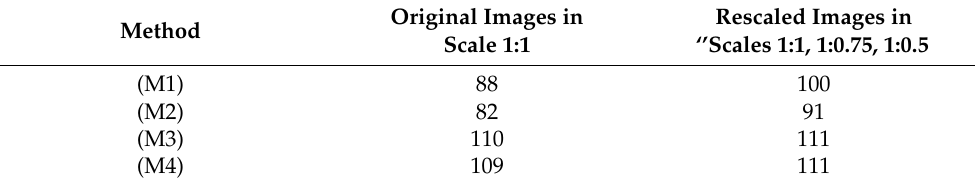
Table 4. Recognition results for repeated runs in multiple scales of